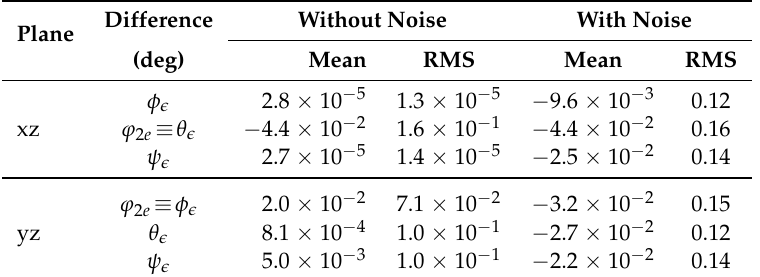
Table 2. Mean and RMS values of differences (deg) between expected and estimated angles. Plane